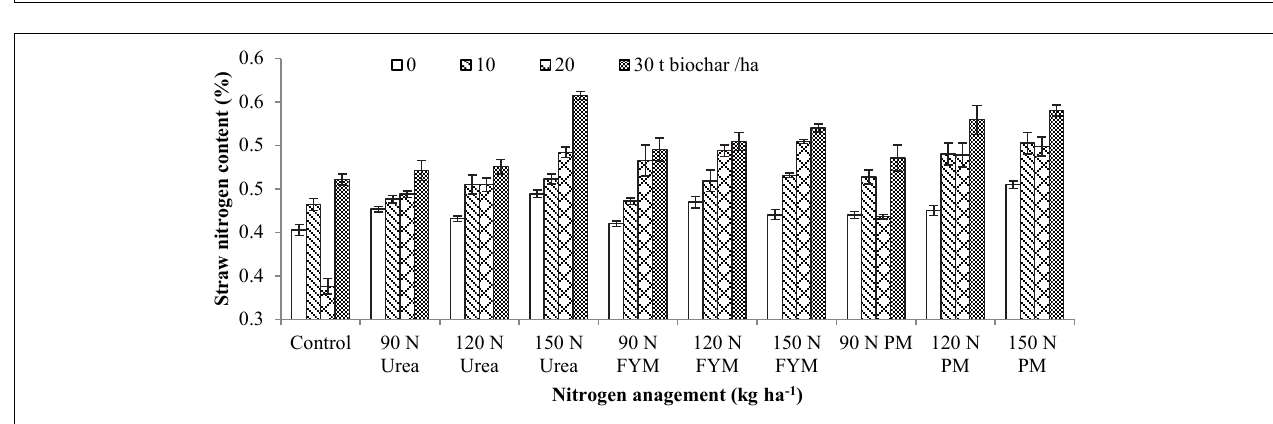
FIGURE 5 | Interactive effect of biochar and N levels applied from different sources on straw nitrogen content of wheat. Bars on graph denote SE of mean ( n = 3). FYM, farmyard manure; PM, poultry manure.